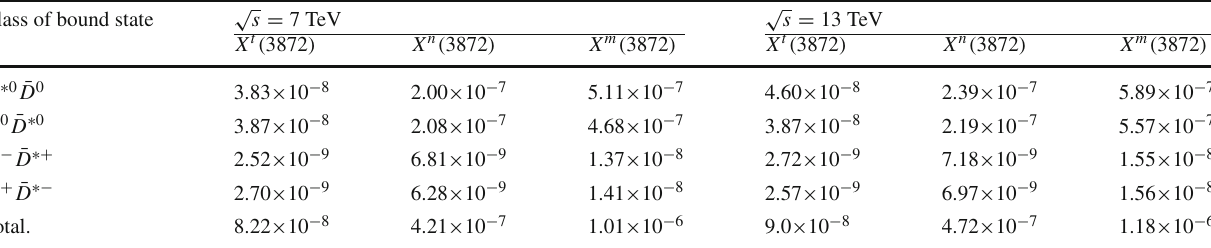
Fig. 1 The distribution of the yield of exotic states X ( 3872 ) in pp collisions with | y | < 1 and 0 < p T < 15 . 5 GeV/c, as a function of mass uncertainty (cid:6) m . The data are calculated using PACIAE+DCPC model as X ( 3872 ) consists of the bound state D ¯ D ∗ , a as X ( 3872 ) consists of the bound states D ∗+ D − and D + D ∗− at b as X ( 3872 ) consists of the bound states D + ¯ D ∗− and ¯ D − D ∗+ at Table 2 The yield of X ( 3872 ) of different structures produced by D ¯ D ∗ clusters in pp collision at GeV/c, computed by the PACIAE+DCPC model, where (cid:6) m = (cid:8)/ 2